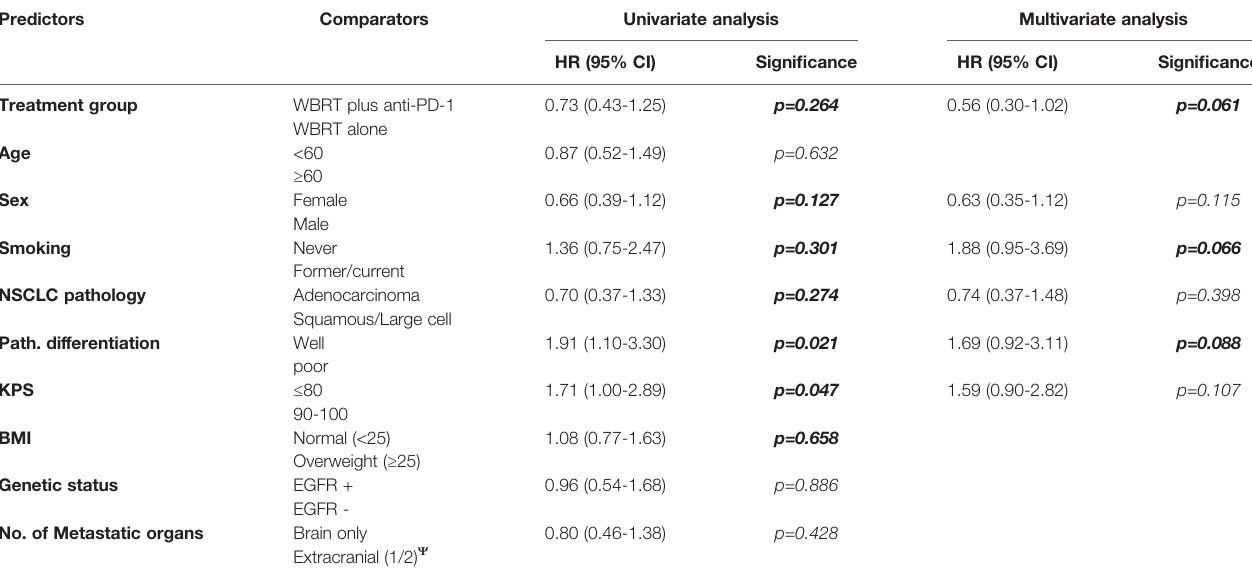
TABLE 3 | Univariate and multivariate analysis for progression-free survival.